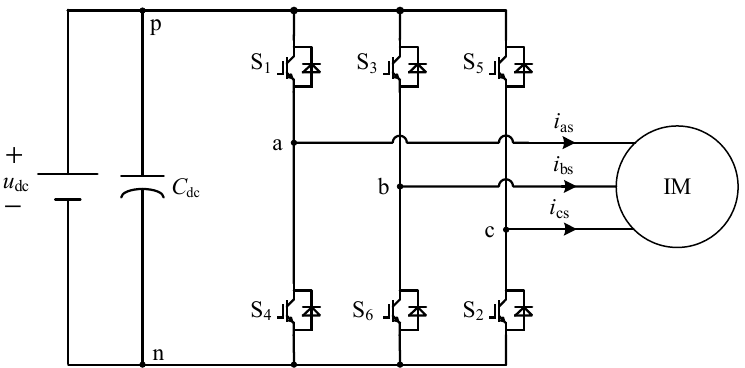
Figure 3. Experimental test of the IM natural frequency.